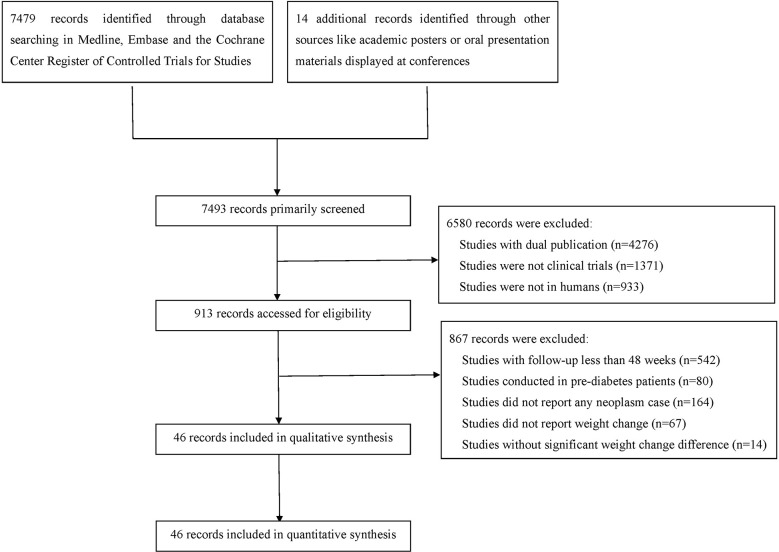
Flow diagram of the included studies.